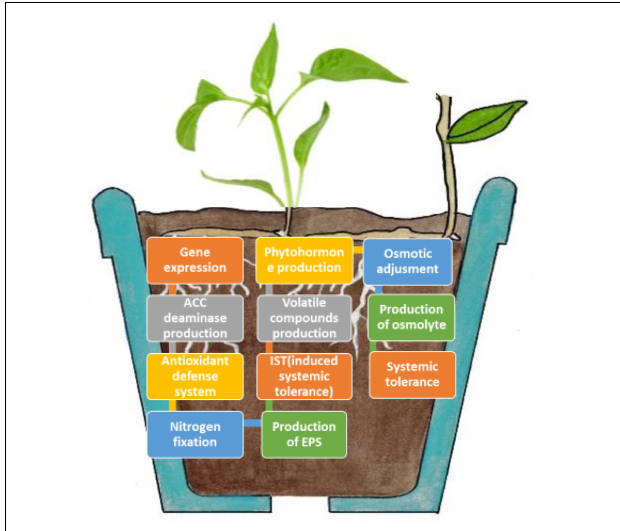
FIGURE 2 | Plant–microbial interactions involved in the mitigation of drought stress.